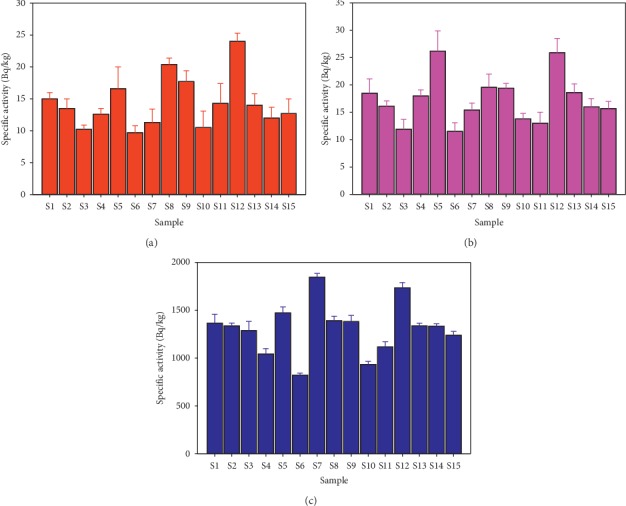
Distribution of (a) 238U, (b) 232Th, and (c) 40K in different sampling points.